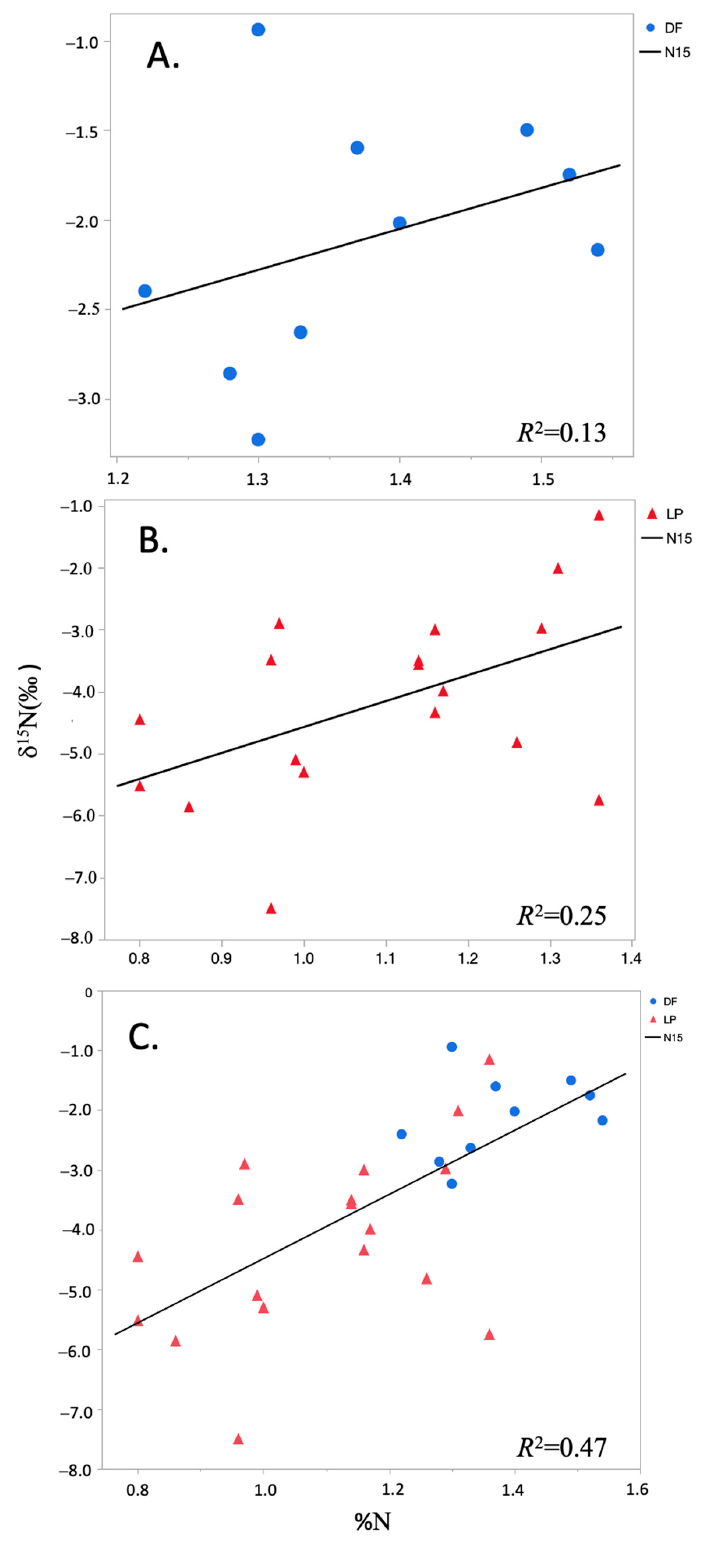
Figure 2. Relationship between foliar nitrogen concentration (%N) and natural abundance foliar δ 15 N (‰) in: ( A ) Douglas-fir; ( B ) loblolly pine; and ( C ) a combined data set of both species (Table 3).